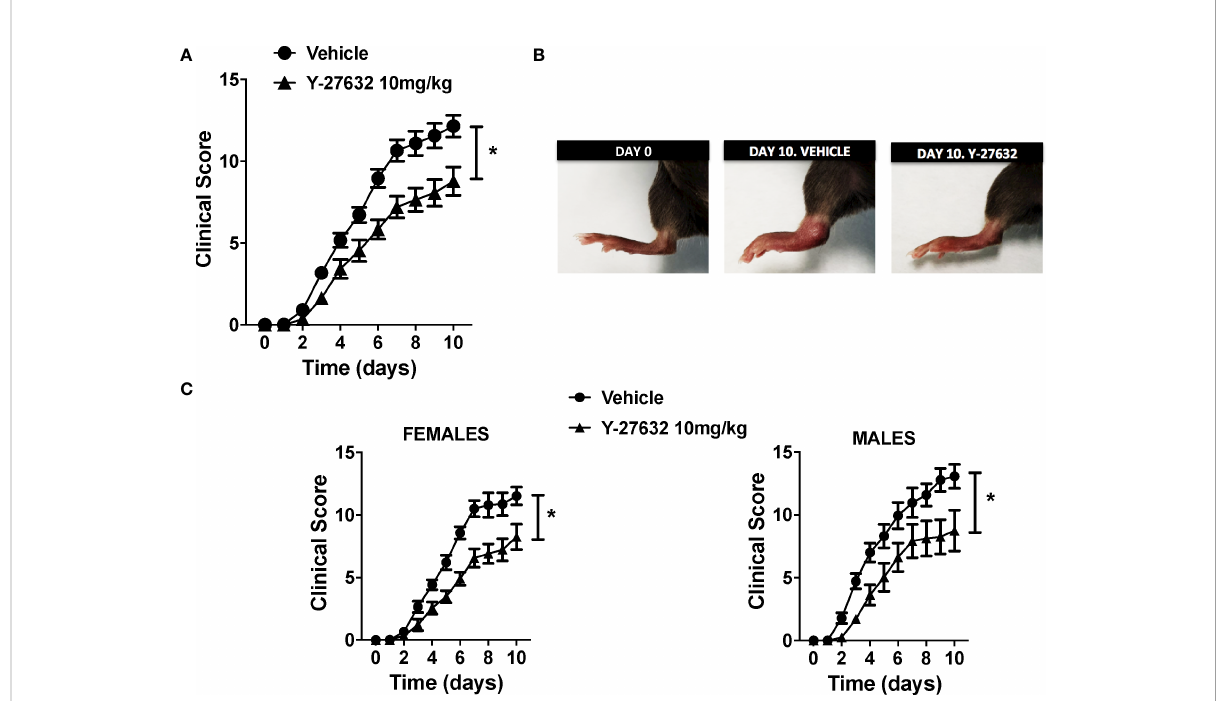
FIGURE 1 ROCK inhibition with Y-27632 reduced the severity of serum-transfer arthritis in mice. (A) Clinical arthritis score in C57BL/6J mice receiving 100 µl of K/BxN serum on days 0 and 2 and treated every day with 10 mg/Kg of Y-27632 (n = 14) or vehicle (n = 15). (B) Representative pictures of a mouse rear paw at day 0, day 10 after arthritis induction and treated with vehicle, and day 10 after arthritis induction and treated with Y-27632. (C) Clinical arthritis scores in 18 C57BL/6 females and 11 males after treatment with Y-27632 or vehicle. Values are the Mean ± Standard error of the mean (SEM). *p < 0.05 (ANOVA repeated-measures test). Y-27632: ROCK